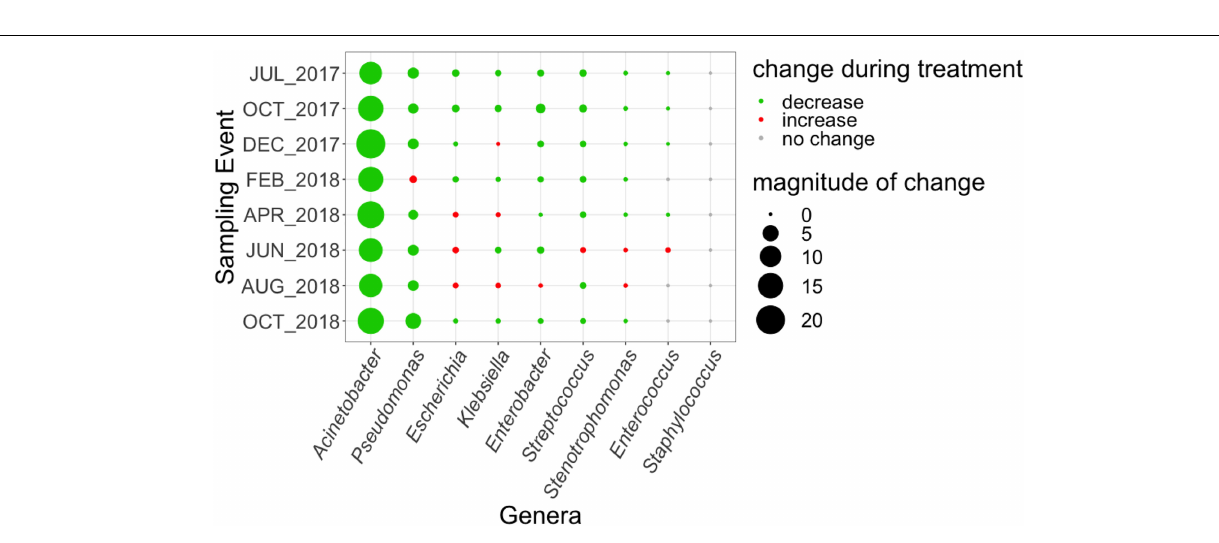
FIGURE 6 | Magnitude of change (based on absolute difference) in relative abundance, as a percentage of corresponding genetic markers quantified from metagenomics data using MetaPhlAn2 (Truong et al., 2015) in influent versus secondary effluent, of pathogen-containing genera tested in the 2017 Virginia state and regional cumulative antibiogram (Virginia Department of Health,